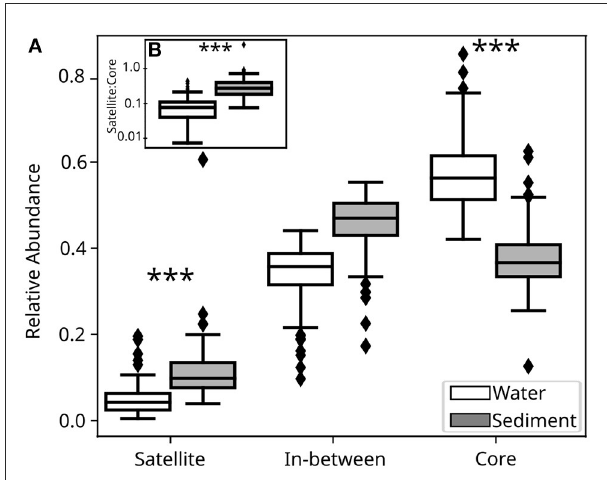
FIGURE1 (A) Boxplots comparing the relative abundance of groups within individual samples from surface water (white) and sediment (gray). The inset (B) shows the satellite:core ratios for individual surface water and sediment samples. The relative abundance is the number of molecular formulae assigned to a group (satellite/in-between/core) to the total number of molecular formulae within a sample, whereas the overall ratio is the number of satellite compounds divided by the number of core compounds. Differences in the medians between sediment and surface water samples for each group were tested using the Kruskal-Wallis H-test. Statistical differences ( p < 0.05) between the medians of sediments and surface waters are denoted with a triple asterisk. Boxplots show the median and first and third quartiles, whiskers extend to the farthest data point (within 1.5 times the interquartile range), and diamonds are